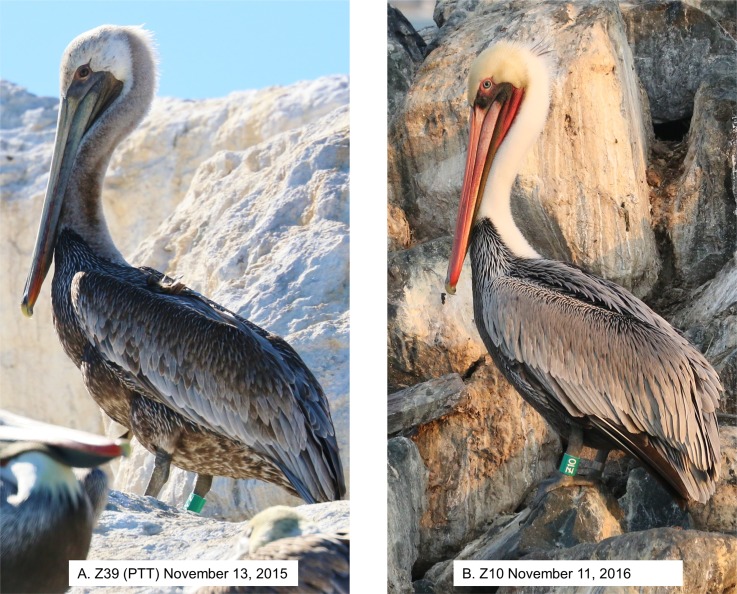
Mid-November brown pelican plumage aspect comparison, lagged versus typical.This example shows lagged molt of a post-spill bird carrying a GPS-PTT tag photographed 6 months after the spill (A) versus seasonally typical molt status in a post-spill bird marked with band-only, photographed 18 months after the spill (B).